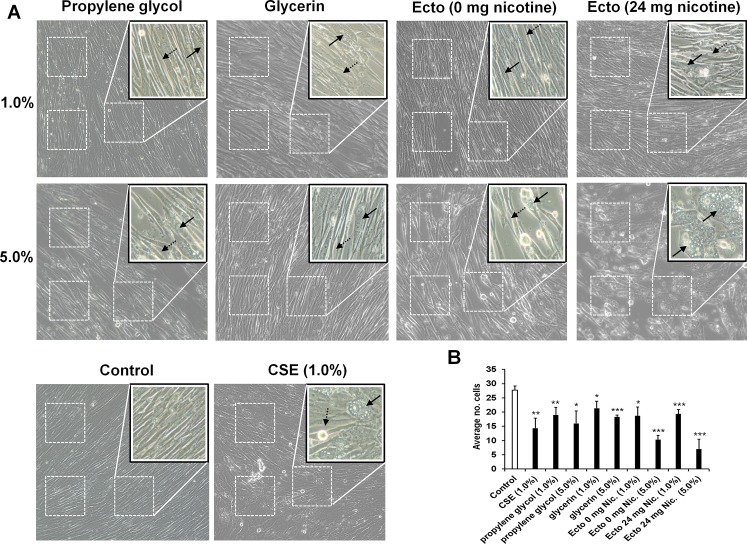
Addition of e-liquids to cell culture media induces morphological changes in human lung fibroblasts.(A) HFL-1 cells grown to 95% confluence were treated with the following e-liquids; propylene glycol, glycerin, or Ecto American tobacco flavor for 24 hrs and then examined for morphological changes by phase-contrast microscopy. Treatment of HFL-1 with 1.0% CSE for 24 hrs included for comparison. Images captured at 20x magnification. Embedded images show expansion of defined area of monolayer as demarcated by dashed boxes. Representative images are shown (n = 3). Enlarged vacuolarized cells in expansion area or large circularized cells (solid arrow), and areas of lost cell-cell connection next to spindle formations (dashed arrow) within defined area vs control. (B) Average number of cells counted adjacently across a single diagonal of 3 defined areas placed randomly (dashed boxes within images). The direction of diagonal cell counts is based on cell orientation in each image. Data are shown as mean ± SD. *P < 0.05; **P < 0.01; and *** P < 0.001 as compared to untreated control culture in growth media.